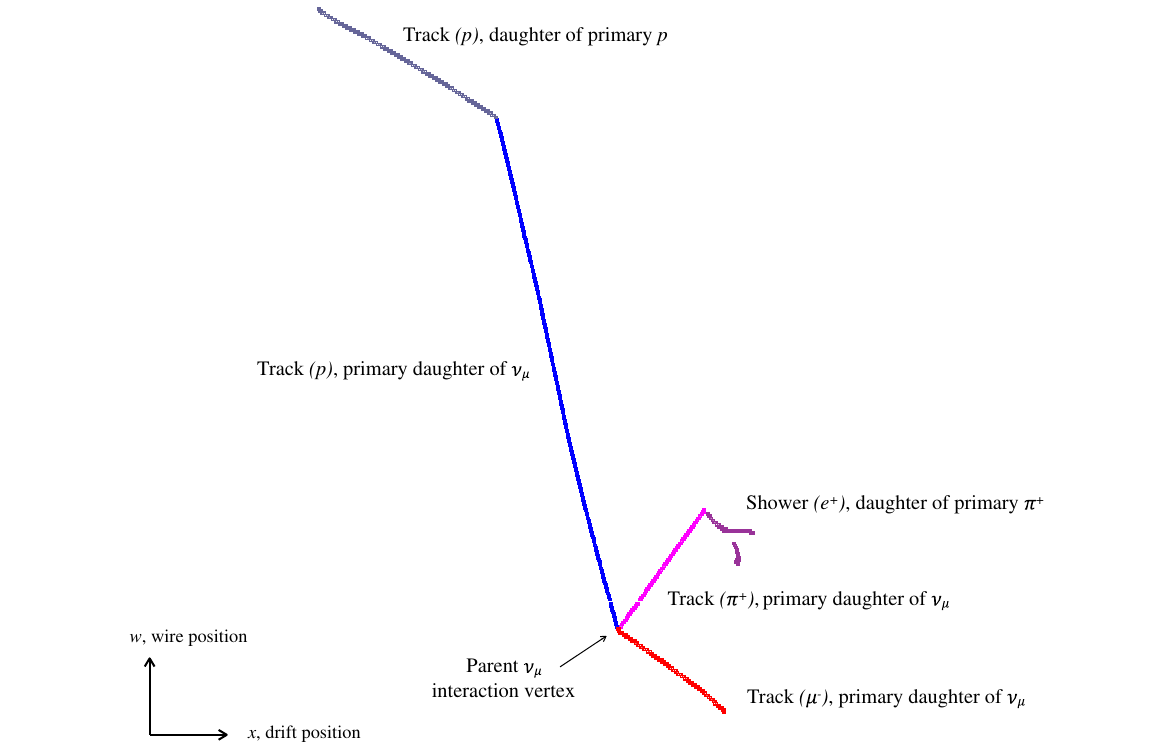
Fig. 9 The hierarchy of particles reconstructed for a simulated CC ν μ event in MicroBooNE with a muon, proton and charged pion in the visible final state. Each reconstructed visible particle is shown in a separate colour. The neutrino particle has a reconstructed interaction vertexandthreetrack-likeprimarydaughterparticles.Thecharged-pion